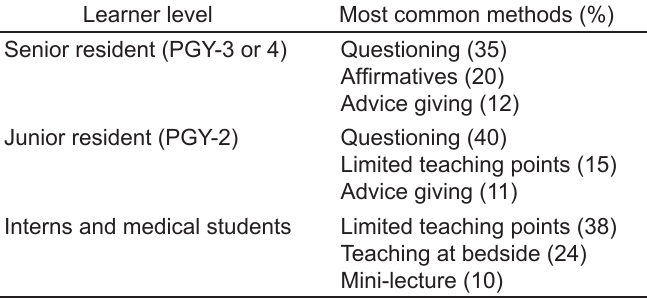
Table 5. Comparison of top three faculty teaching methods used based on level of